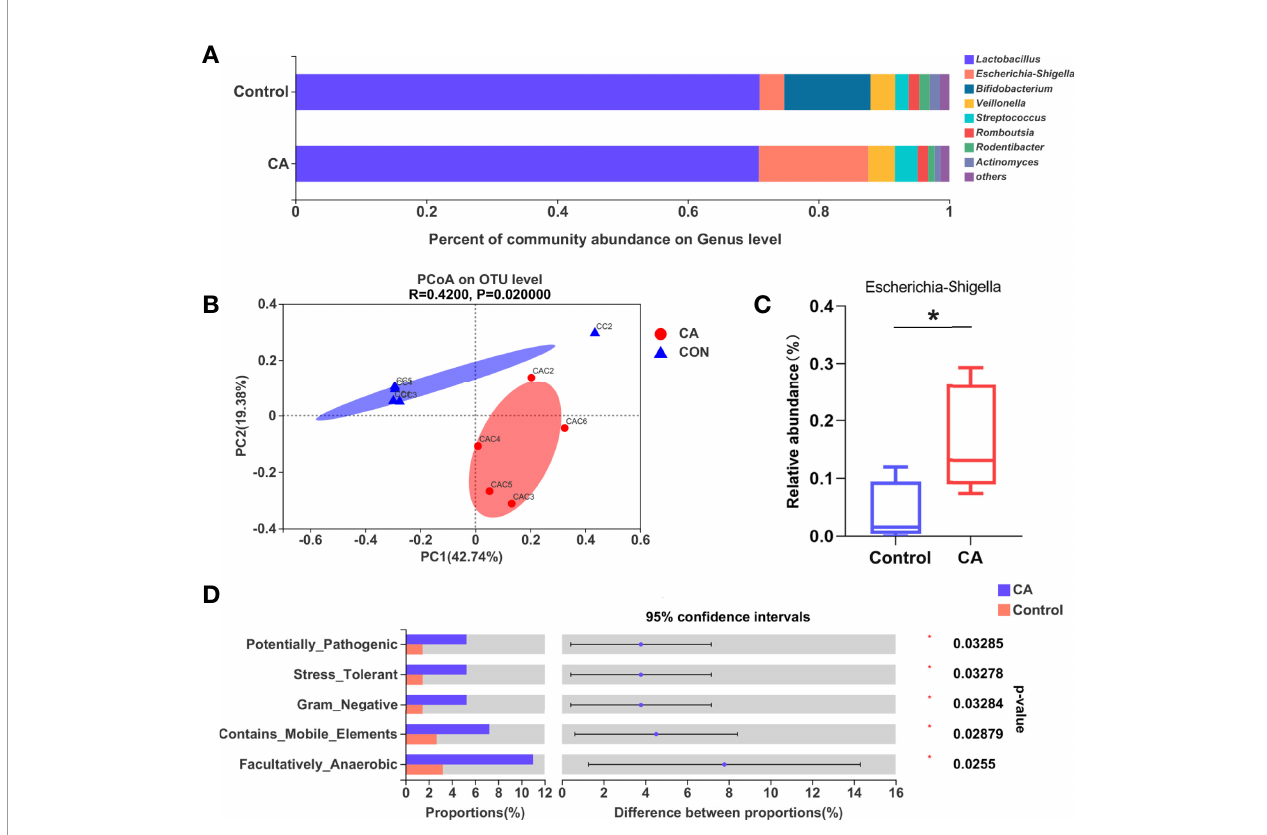
FIGURE 4 | Gut microbiota is altered in the offspring from CA-fed mothers. (A) Composition of gut microbiota of two groups on genus level. (B) PCoA on OTU level. (C) Relative abundance of Escherichia Shigella genera in two groups. (D) Microbial phenotype prediction by BugBase. *p < 0.05. N =